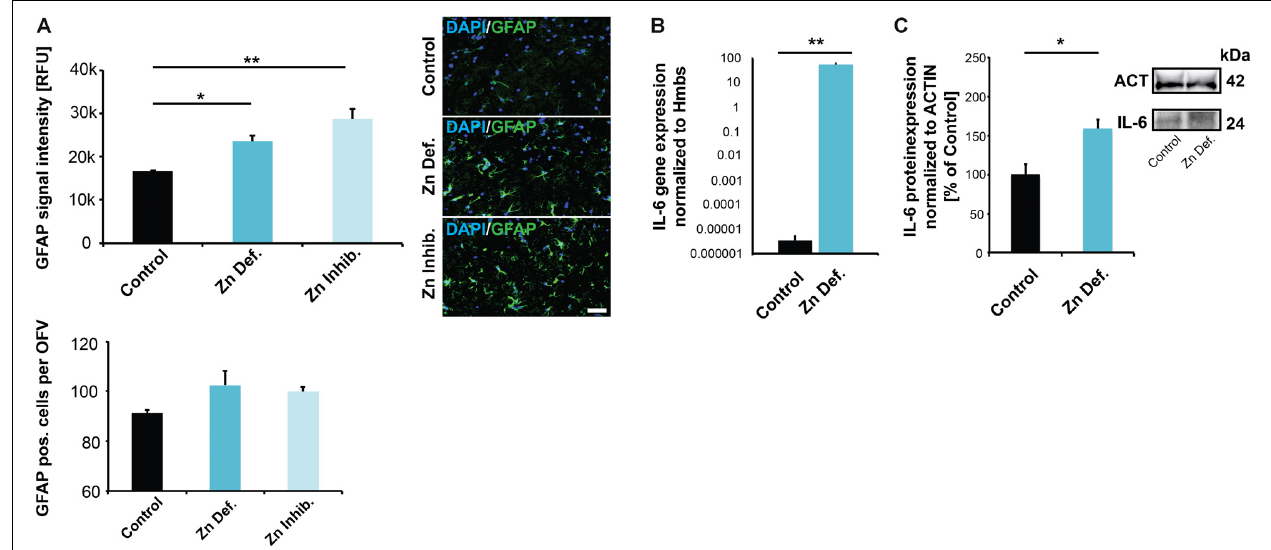
FIGURE 4 | (A) Brain sections from three animals per group were used for immunohistochemistry. DAPI (labeling cell nuclei) and GFAP was visualized and fluorescent signal intensities from 10 cells in the hippocampus from three sections per animal measured. Mean values show the average of three animals per group. Upper panel: A significant increase in GFAP expression levels can be detected in the brains of mice subjected to zinc deficiency and lowered bioavailability (Zn Inhibitor) compared to control mice. Lower panel: No significant difference in the number of GFAP positive cells per optic field of view (OFV) was found. Scale bar = 100 µ m. (B) Whole-brain total RNA lysate from three animals per group was used to analyze the expression of IL-6 on gene level normalized to Hmbs. A significantly higher IL-6 expression was found in the brain of zinc-deficient mice. (C) Whole-brain protein lysate from three animals per group was used to analyze IL-6 expression on protein level normalized to ACTIN. Significantly higher IL-6 levels are found in the brain of zinc-deficient mice.